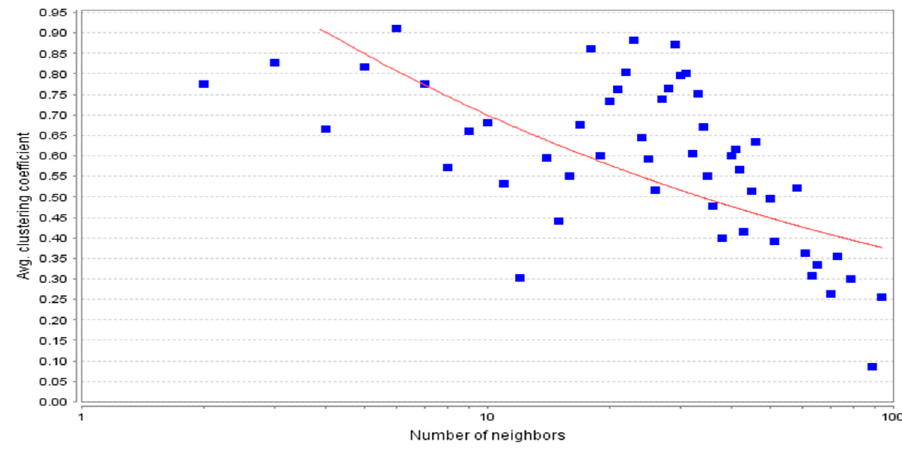
Figure 7. Average (Avg.) clustering coefficient following power law fitting y = 1.326 x − 0.277 (R-squared 0.329). Clustering coefficient distribution of 0.597.